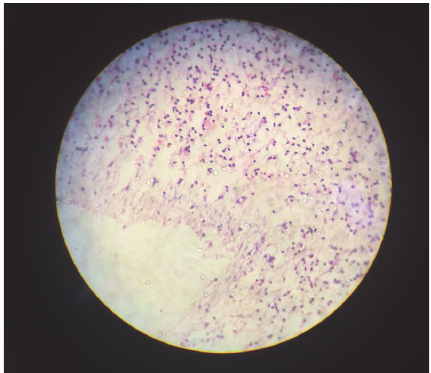
Figure 6: The histologic examination results revealed that the surrounding tissue consists of connective tissue and inflammatory cells and root structure is normal.